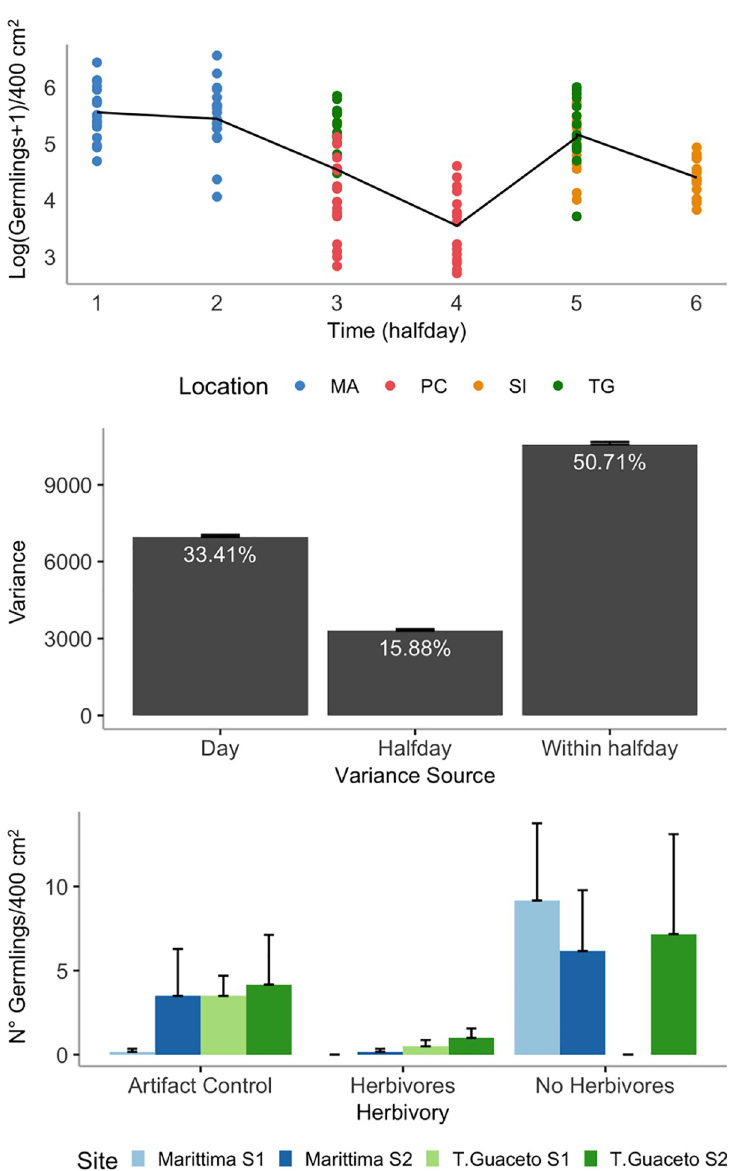
Fig 2. Mortality of germlings during outplanting and in the early stages of growth. (A) Log-transformed number of germlings per tile outplanted in different halfdays of the outplanting phase. Tiles outplanted in different locations are shown with dots of different color. The black line represented the predicted linear mixed-effect model. (B) Variance components of the number of germlings per tile during the outplanting phase. Variance is estimated among days of outplanting, between halfdays within each day and among tiles within each halfday. (C) Number of germlings per quadrat in different Herbivory conditions at different sites after 3 months from outplanting.